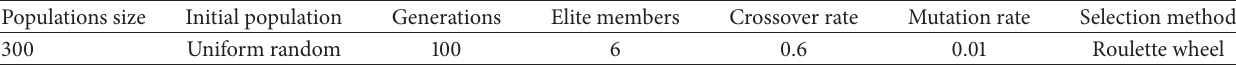
Table 2: Settings for the GA.